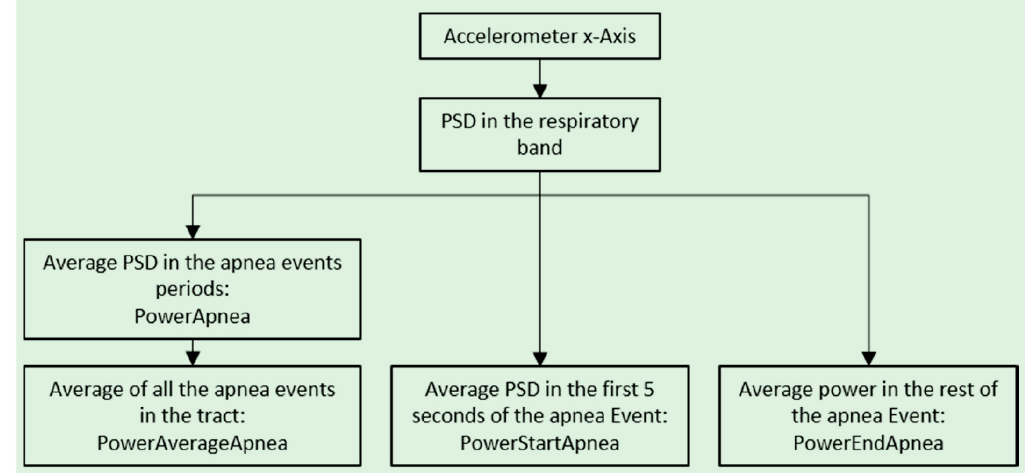
Figure 16. Detailed scheme of the average Power and Power Spectral Density (PSD) calculation.